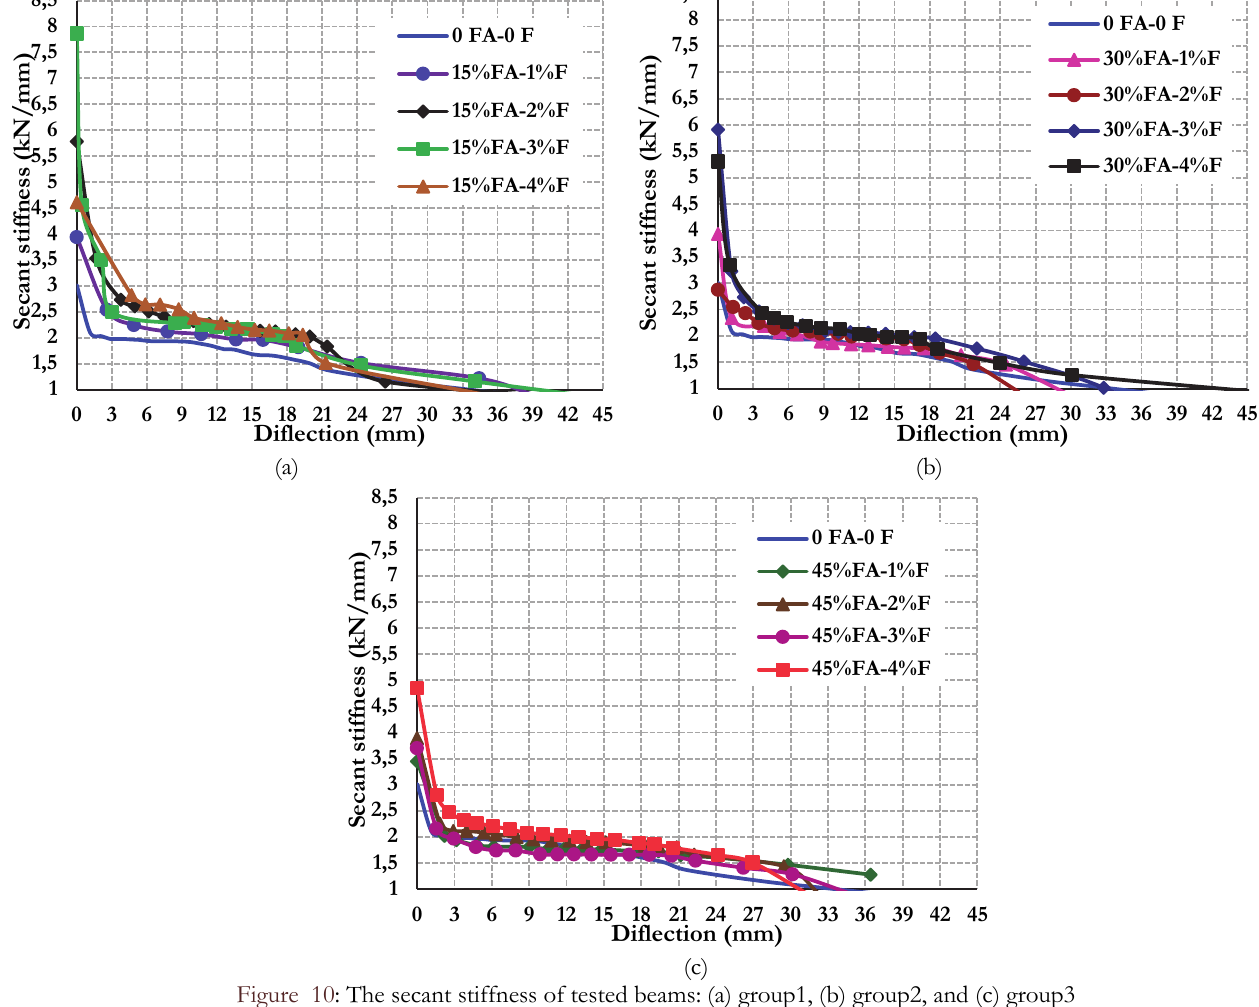
Figure 10: The secant stiffness of tested beams: (a) group1, (b) group2, and (c) group3